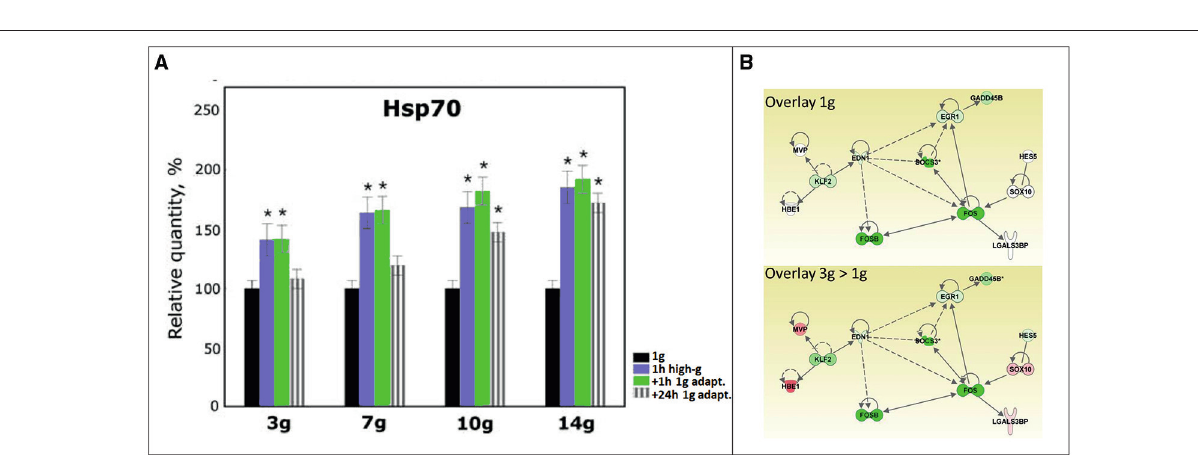
FIGURE 3 | (A) Example Hsp70 content of pea seedlings exposed to 1 h hyper-gravity levels ranging from 3 to 14 g. After HG exposure the seedlings were left for either 1 or 24 h to re-adapt to 1 g. Data are means ± SD . * indicate values that are statistically different from control ( p ≤ 0.05 ). (Reproduced from Kozeko and Kordyum, 2009 , with permission). (B) Example of a Reduced Gravity Paradigm experiment execution. A specific gene network was identified that specifically responds to a 1 day reduced gravity, i.e., going from 5 days at 3g to 1 day at 1g (from Aceto et al.,